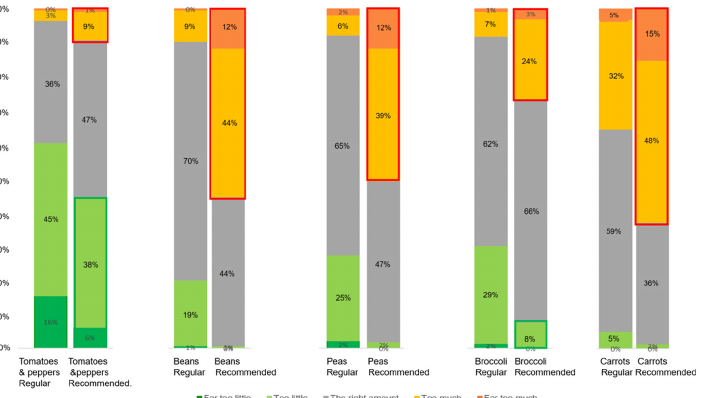
Figure 5. Bar plots of the perceived amount of vegetables (from “far too little” to “far too much”) in the regular and recommended portions of each of the five meals.